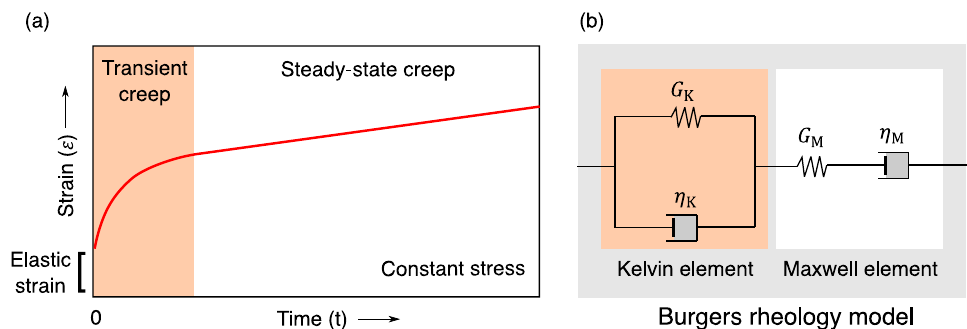
Fig. 3 Schematic diagrams of the transient deformation of rocks under constant stress. a The time-dependent strain of mantle rock under constant stress. b Spring–dashpot representation of biviscous (Burgers) rheology. G K and G M denote shear modulus of the Kelvin element and the Maxwell element, respectively. η K and η M represent viscosity of the Kelvin element and the Maxwell element,